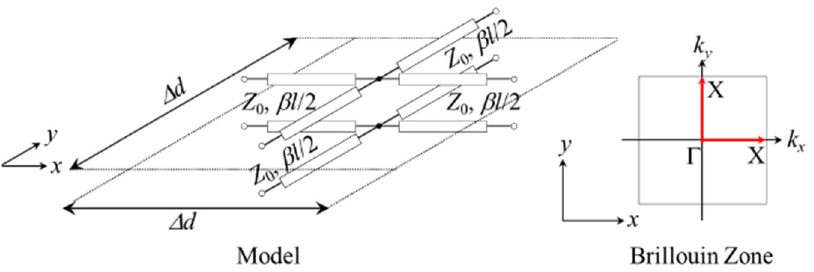
Figure 1. Distributed transmission-line model for the design of NRI acoustic metamaterials. The red arrows show the Γ -X pass ( k x = k and k y = 0 or k y = k and k x = 0) in the Brillouin Zone.